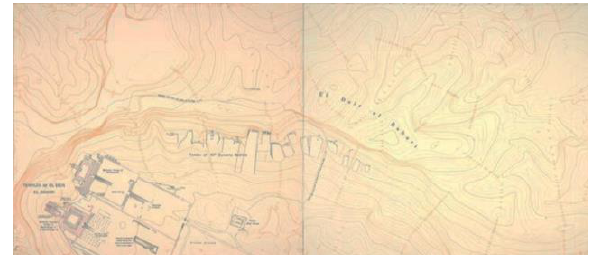
Figure 5: The Funerary Complex of Thebes, Luxor, Egypt.